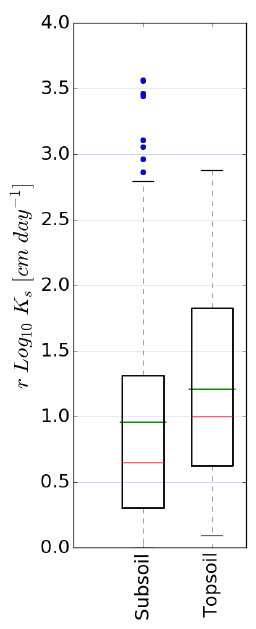
Figure 2. Uncertainty of the standard error of the observed K s in topsoil and subsoil. The lines in the box show upper and lower quar- tiles, the median (red), and mean (green). Whiskers show values within 1.5 times the quartile spread; values outside this range are shown as plotted